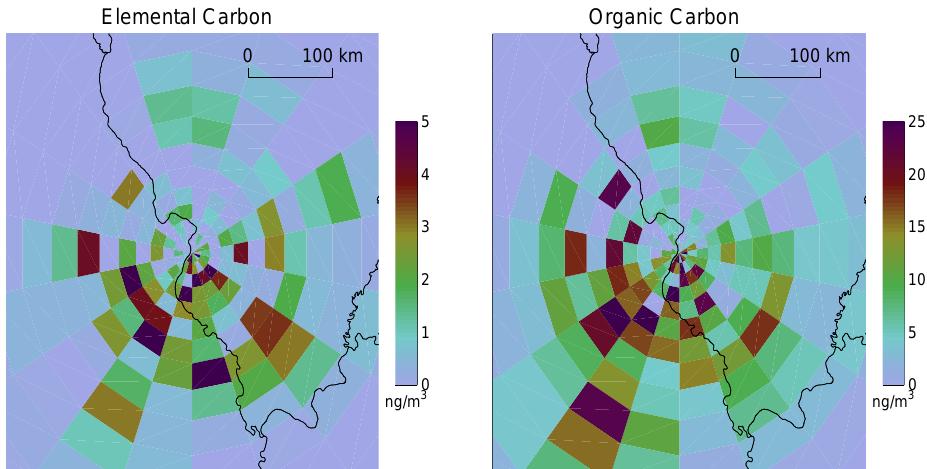
Figure 15. Contributions to the average 2002 concentration of EC and OC in the inverse time series from the residence time analysis grids.